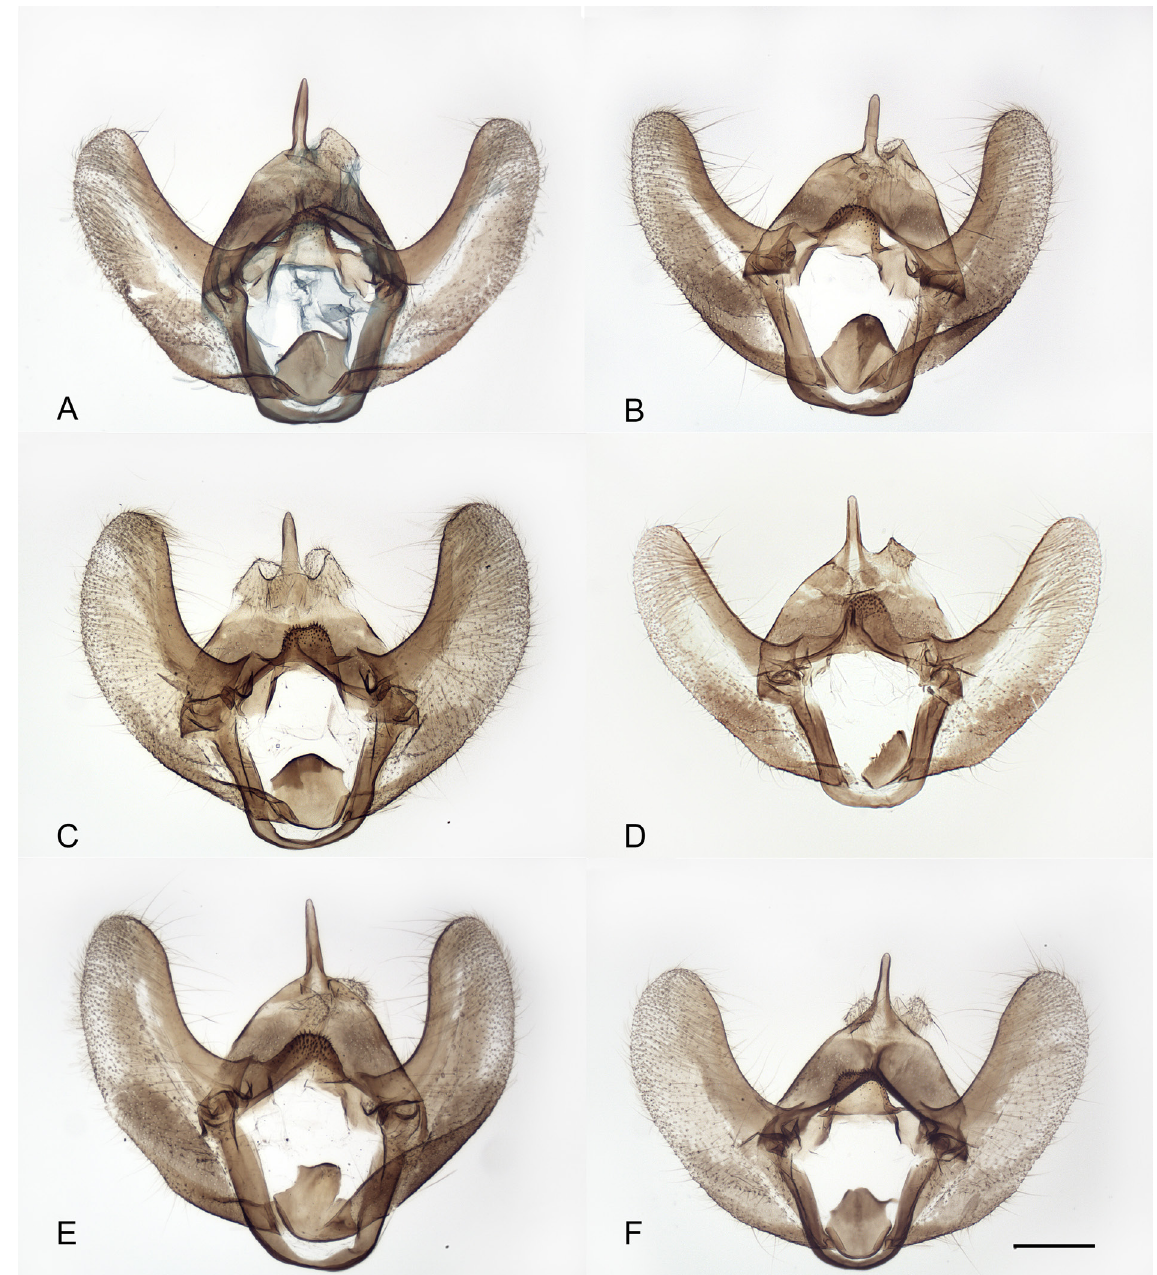
Fig. 2. Male genitalia (without phalli) of Phtheochroa spp. A–B . P. schawerdae (Rebel, 1908)